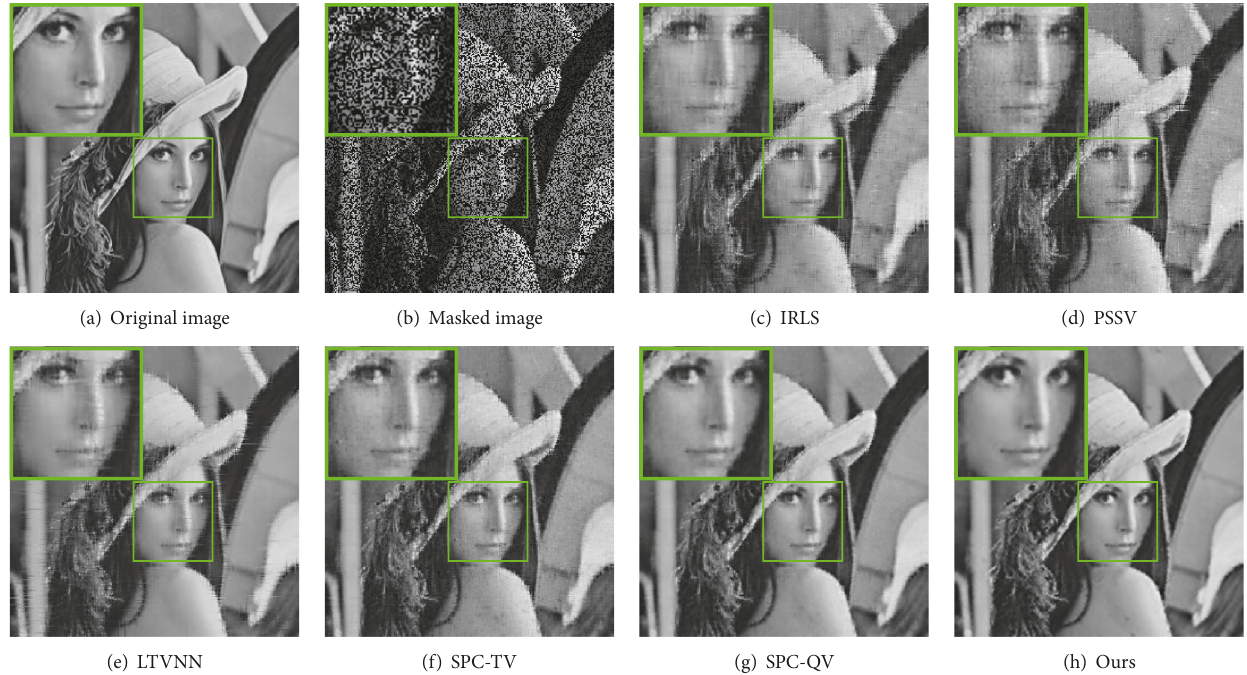
Figure 6: Visual results on Lenna image with 60% missing ratio by different algorithms. (a) Original image. (b) Randomly masked image. (c) IRLS: PSNR=22.91dB, SSIM=0.707. (d) PSSV: PSNR=23.21dB, SSIM=0.696. (e) LTVNN: PSNR=24.91dB, SSIM=0.853. (f) SPC-TV: PSNR=25.24dB, SSIM=0.801. (g) SPC-QV: PSNR=27.50dB, SSIM=0.898. (h) Ours: PSNR=28.96dB, SSIM=0.936. The figure is better viewed in zoomed PDF.